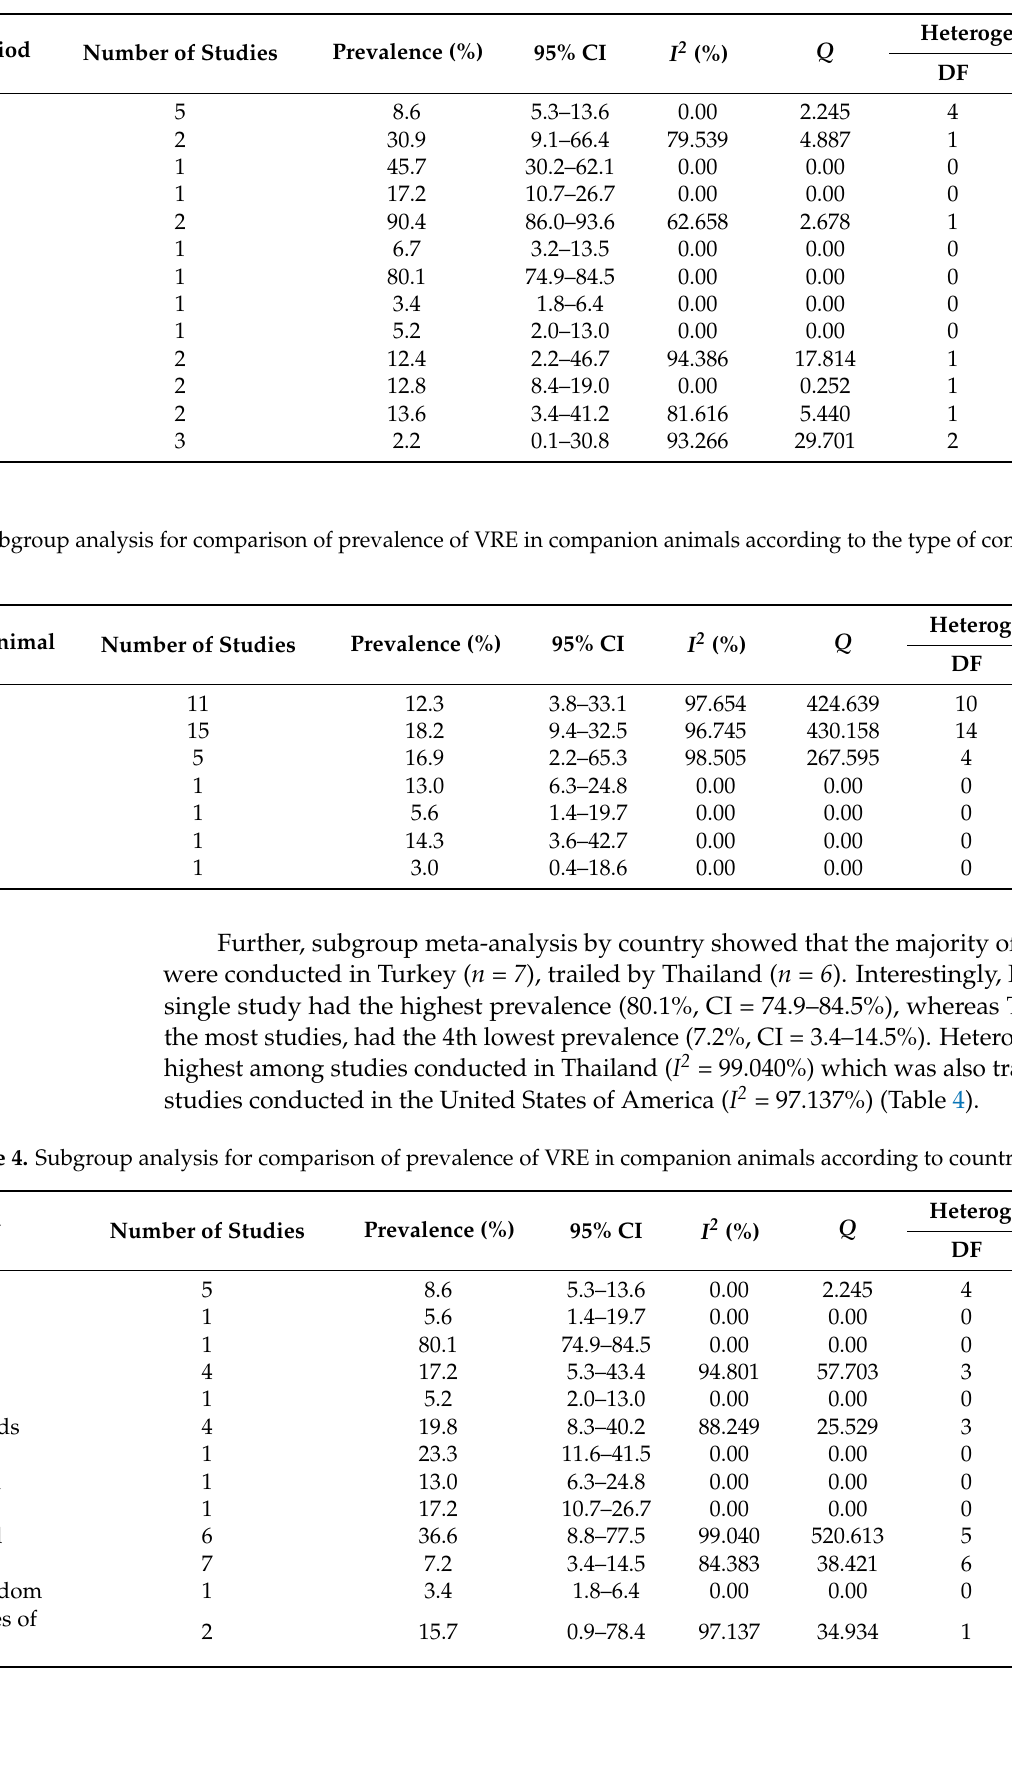
Table 2. Subgroup analysis for comparison of prevalence of VRE in companion animals across sampling periods.